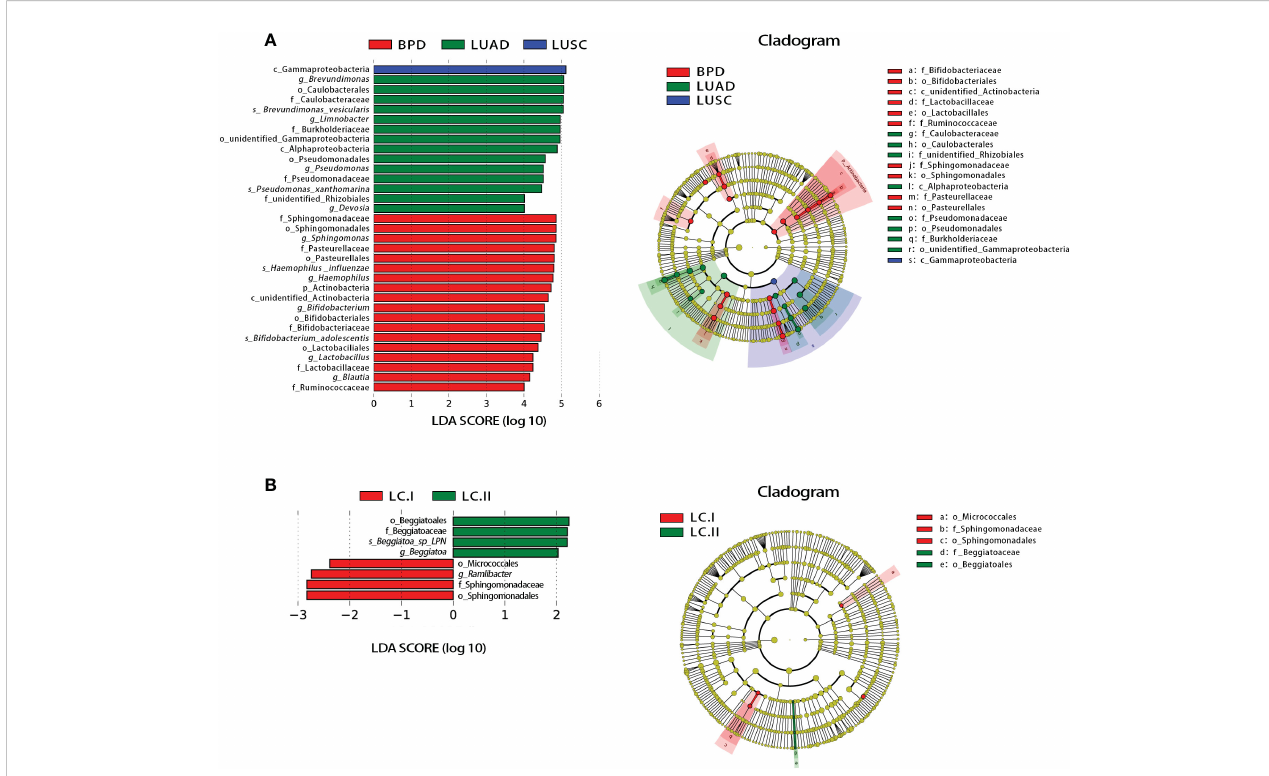
FIGURE 4 Linear discriminant analysis (LDA) effect size (LEfSe) analysis for respiratory microbiota abundance based on lung lesion pathology and lung cancer TNM staging. (A) The LDA scores (>4) and cladogram of the representative taxa associated with lung cancer and BPD. (B) The LDA scores (>2) and cladogram of the representative taxa associated with different lung cancer TNM